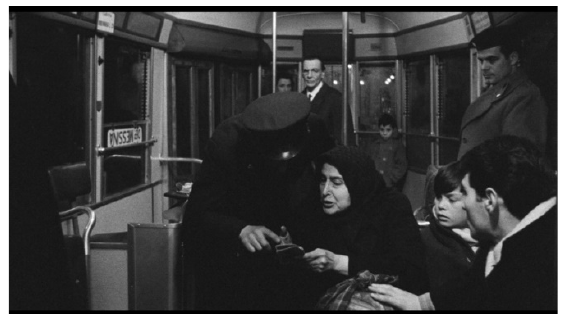
Figure 7 Screenshot from Rocco and His Brothers. (Goffredo Lombardo.)